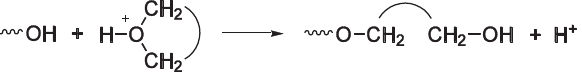
Figure 30. Chain growth via an activated monomer.